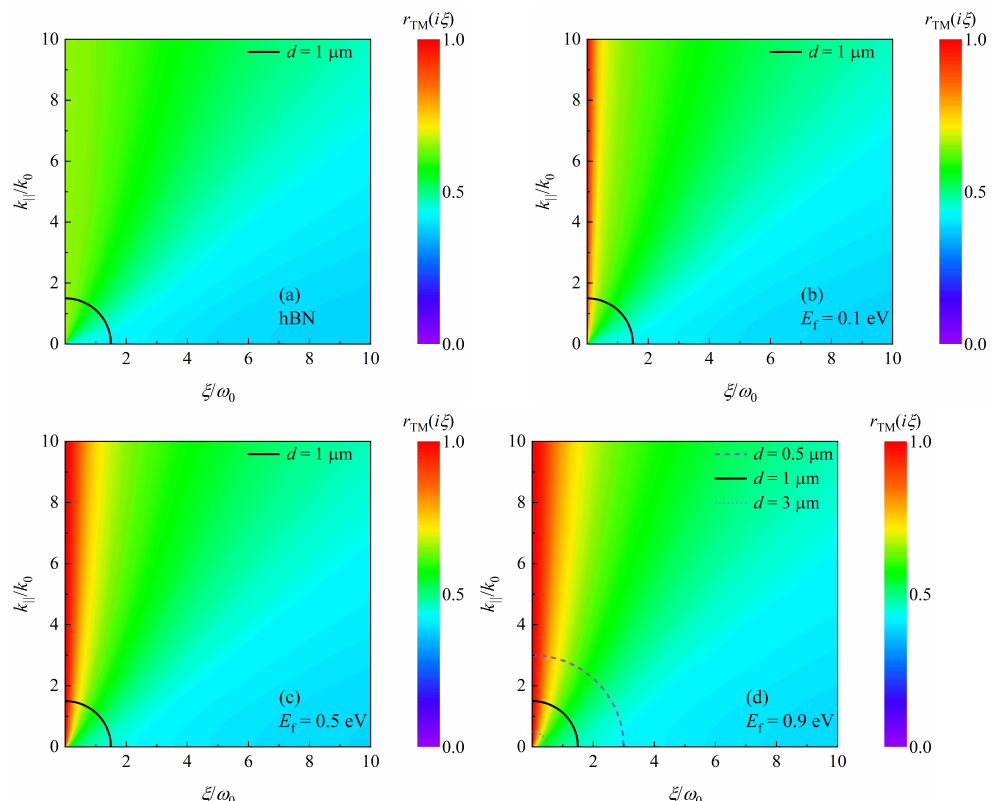
Figure 5. r TM ( i ξ ) as function of ξ and k || . ( a ) is the case of hBN. ( b – d ) are the cases of graphene- covered hBN with Fermi levels ( b ) E f = 0.1 eV, ( c ) E f = 0.5 eV and ( d ) E f = 0.9 eV, respectively. Solid curves in panels ( a – d ) indicate the arc of a circle ξ 2 / c 2 + k 2 Dashed and dotted lines in panel ( d ) indicate the cases for d = 0.5 µ m and d = 3 µ m,